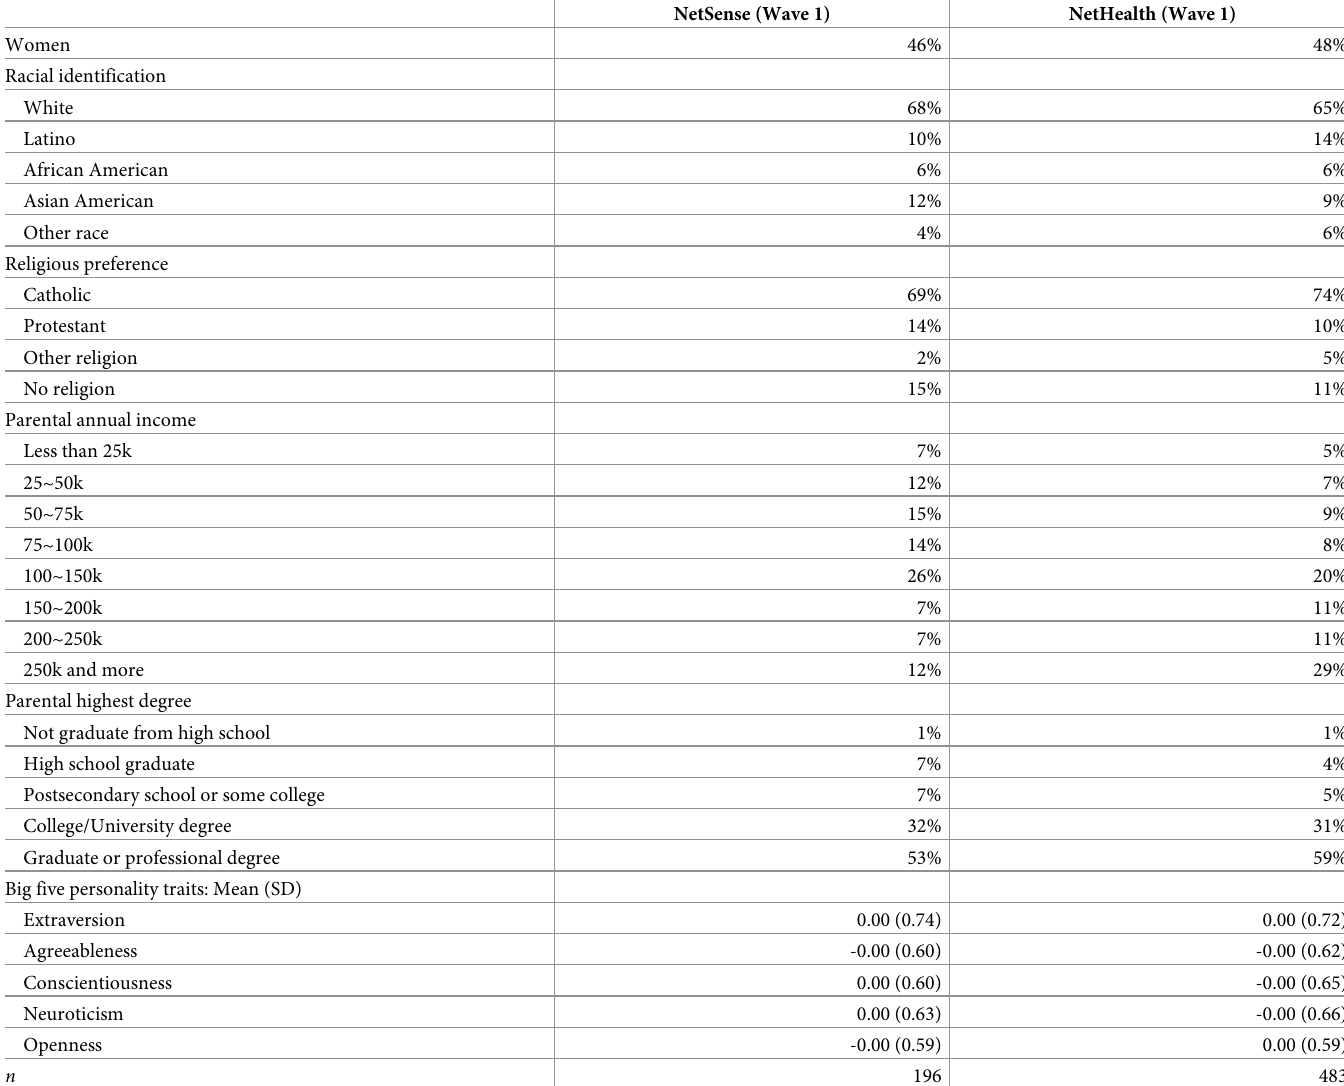
Table 3. Summary statistics of demographic, religious, socioeconomic, and cognitive factors among NetSense and NetHealth study